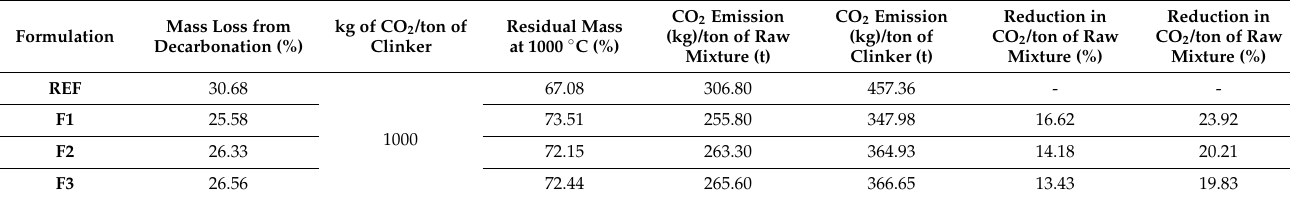
Figure 7. Thermogravimetric analysis of the raw clinker mixtures. Table 5. Thermogravimetric analysis of the raw clinker mixtures.